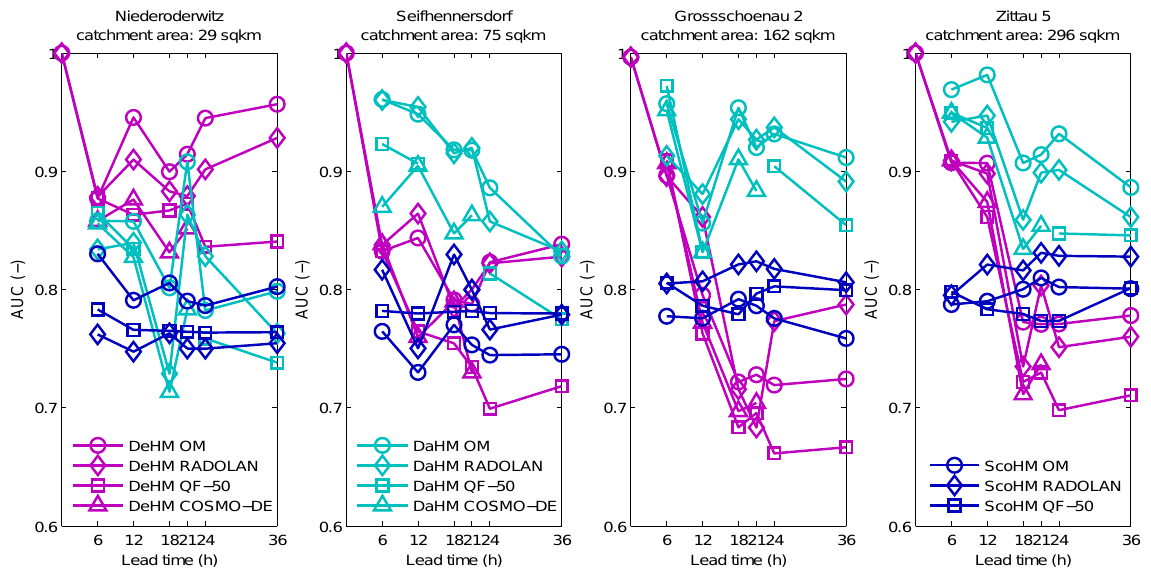
Figure 6. Results of hourly, threshold-oriented evaluation for DeHM, DaHM and ScoHM output in the Mandau pilot area, based on Area Under Curve values. Lead times range from 6 to 36h, update cycle is 12h. OM: ombrometer data (i.e., gridded rain gauge data); RADOLAN: QPE from weather radar scans; QF-50: 50th percentile of Quantile Forecast; COSMO-DE: numerical weather prediction output. Skill for DeHM at a lead time of zero is based on true model output after assimilation/updating and can be slightly smaller than unity (e.g., apparent for Großschönau